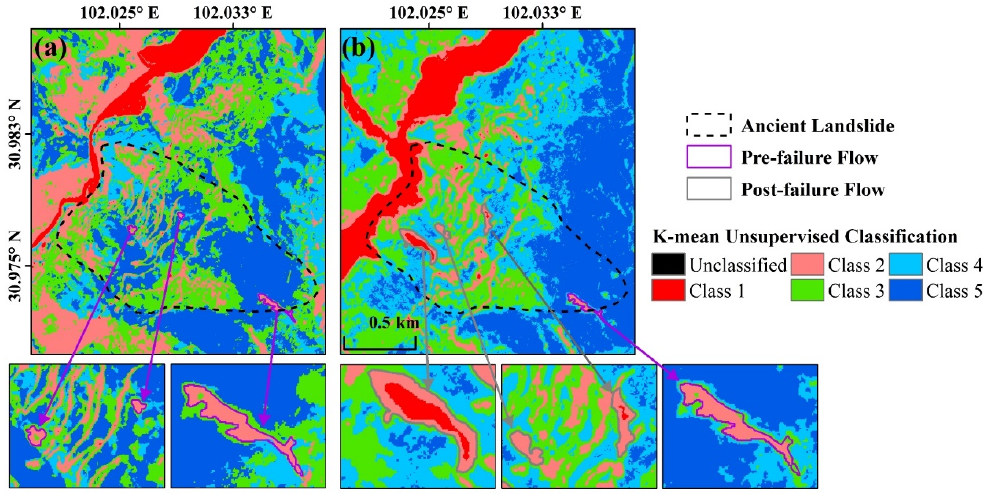
Figure 6. K-mean unsupervised classification based on the time-series ARVI images: ( a ) pre-failure